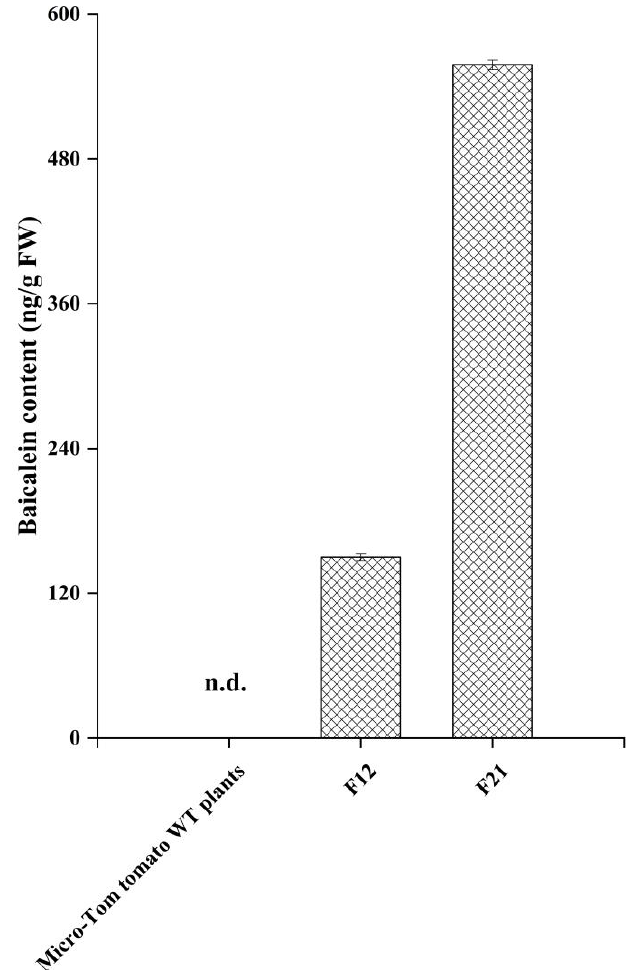
Figure 5. Average baicalein content (ng/g fresh weight) in the fruits of transgenic Micro-Tom tomato lines. n.d.: not detected. The data are represented as mean ± SD for the three independent experiments.